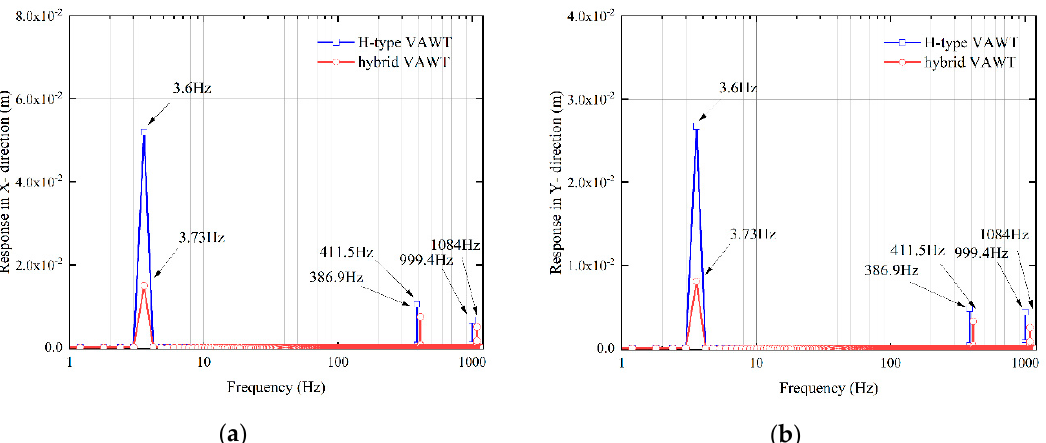
Figure 11. ( a ) Amplitude ‐ frequency responses of the 1 m ‐ mast H ‐ type and hybrid VAWTs in ( a ) X and ( b ) Y directions.